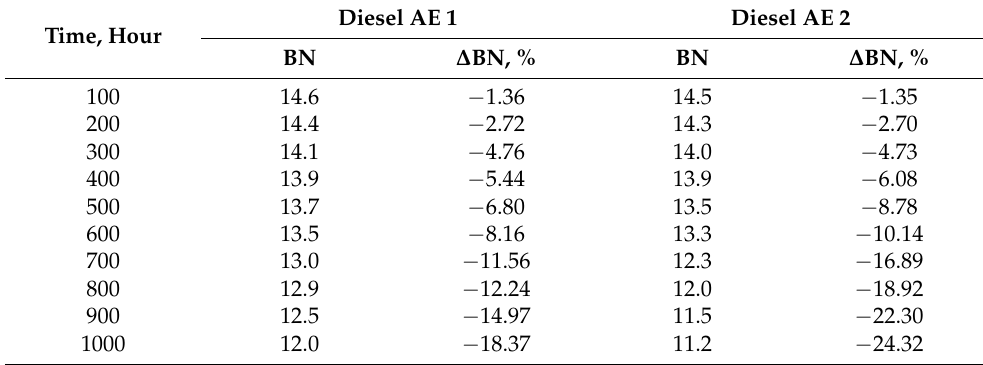
Table 2. Change BN and ∆ BN oils Shell Gadinia AL 40 under different experimental conditions. Time,